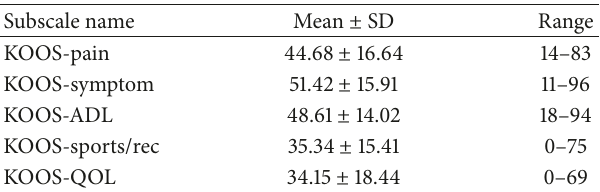
Table 1: Descriptive values for KOOS subscales in radiographic OA knee patients ( 𝑛 = 119